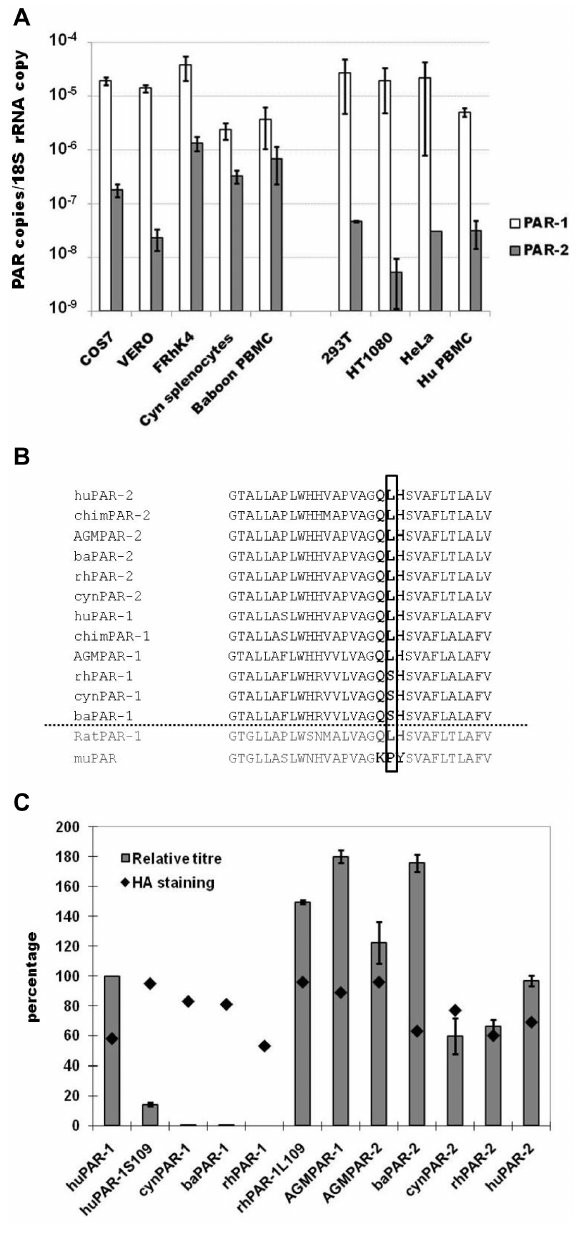
Figure 3. Endogenous expression, sequence and function of NHP PERV-A receptors. A ) Total RNA was extracted from NHP and human cells and analysed by quantitative RT-PCR. Primers used for amplification of NHP PAR-1 (white bars, left) huPAR-1 (white bars, right) NHP PAR-2 (grey bars, left) and human PAR-2 (grey bars, right) are listed in Table S1. PAR copy number was calculated from standard curves and normalised per 18S rRNA copy. Histograms represent average of at least two independent experiments ( 6 SEM). B ) Human (huPAR-1 and huPAR-2), mouse (muPAR), rat (ratPAR), chimpanzee (chimPAR-1 and chimPAR-2), rhesus macaque (rhPAR-1 and rhPAR-2) PAR and baboon PAR-2 (baPAR-2) sequences were present in the NCBI database. African green monkey (AGMPAR-1 and AGMPAR-2), cynomolgus macaque (cynPAR-1 and cynPAR-2) and baboon (baPAR-1 and baPAR-2) PAR sequences were obtained by RT-PCR of RNA extracted from NHP cell lines and primary cells using specific primers (Table S1). Deduced amino acid sequences were aligned using ClustalW software. The three amino acids different between muPAR and huPARs are in bold and the amino acid 109 critical for PERV-A receptor function as previously described [42] is boxed. C ) C-terminal HA-tagged PAR sequences were cloned